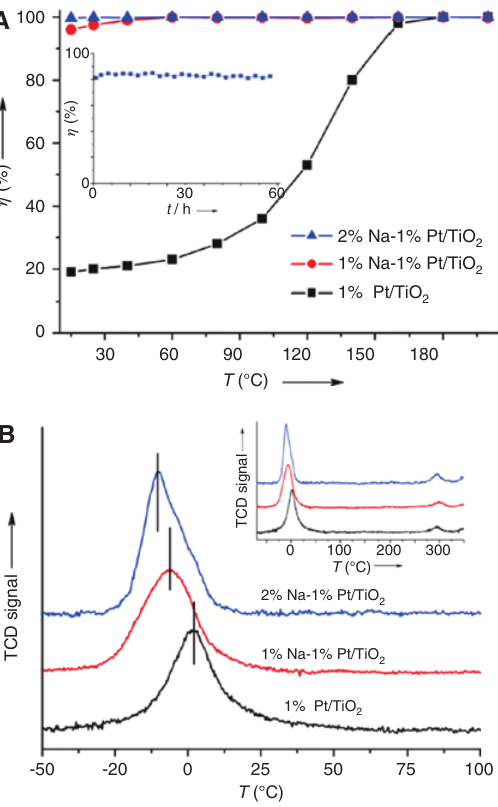
) and 15% ( T ) conversion of 50 15 Figure 11: (A) HCHO conversion η over x wt.% Na-1 wt.% Pt/TiO 2 ( x = 0, 1 and 2) catalysts as a function of temperature T . Reaction conditions: HCHO δ = 600 ppm, O 20 vol.%, relative humidity: 2 about 50%, He balance, total flow rate of 50 cm 3 min -1 and GHSV 120,000 h -1 (inset: stability test of 2% Na-1% Pt/TiO at 25 ° C, GHSV 2 300,000 h -1 with same other reaction conditions). (B) H -TPR profiles 2 of x wt.% Na-1% Pt/TiO ( x = 0, 1 and 2). Reproduced from [70] with 2 permission from